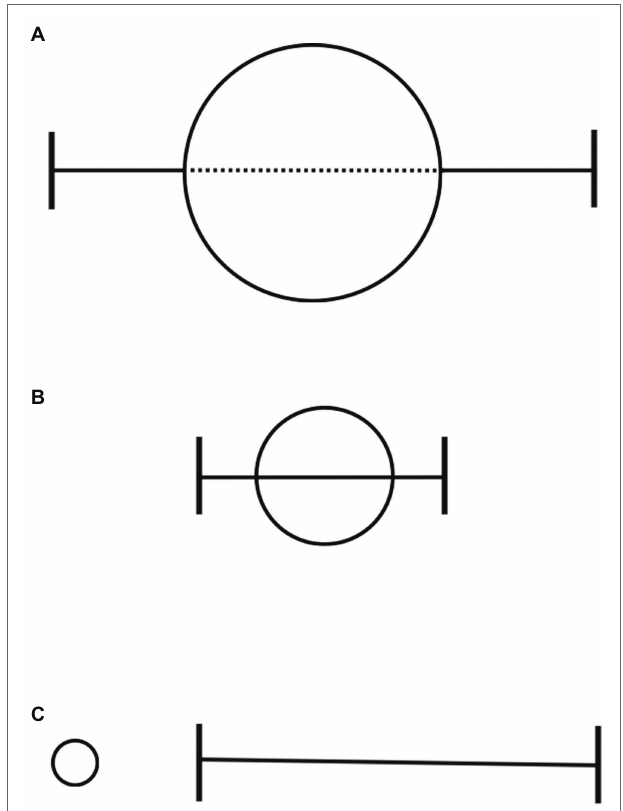
FIGURE 1 | Functional units for existing models combining ketamine with psychotherapy. Each circle indicates a single experience of ketamine, with circle size corresponding to relative theoretical emphasis on the nature of the experience. Bracketed lines are used to indicate optimal windows of psychotherapeutic intervention. (A) shows the strategy of high-dose “psychedelic therapy,” involving significant preparation before and integration after a limited number of drug sessions, which themselves are largely inner- directed, rather than primarily relational, experiences. (B) shows the model of low-dose “psycholytic therapy,” in which ongoing psychotherapy coincides with ketamine administration, making use of acute drug effects that are thought to facilitate the quality of therapy. The two former approaches are examples of “experience-oriented” frameworks, such as KAP. (C) is representative of “plasticity-oriented” strategies, wherein psychotherapy is delivered after the period of acute drug effects but within “critical periods” of neural adaptation that are thought to facilitate the uptake and efficacy of behavioral